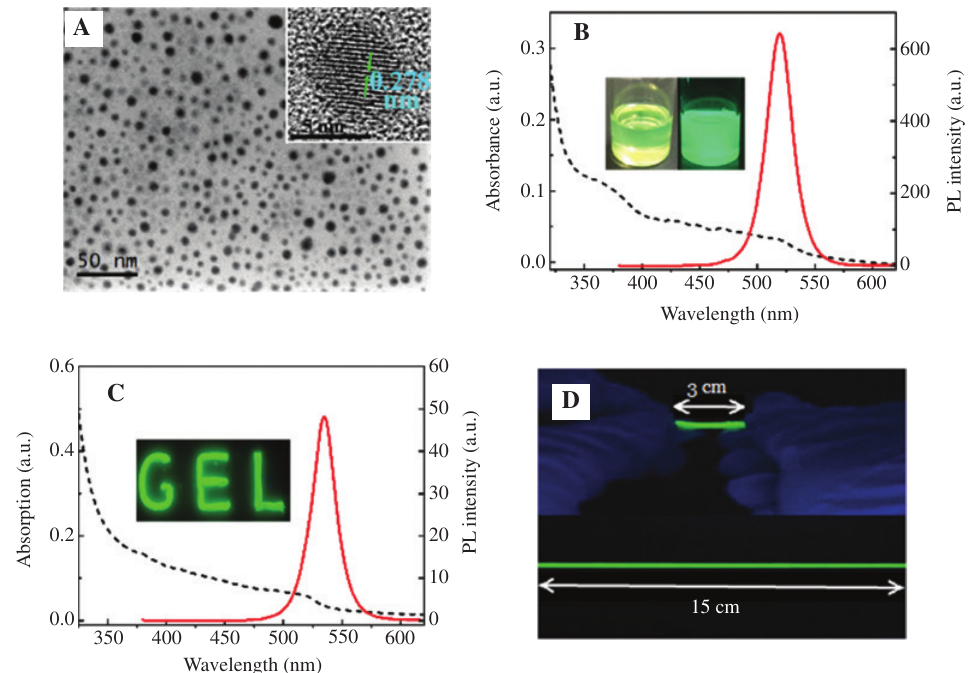
NCs. Inset: the HRTEM image; (B) UV-Vis absorption and PL spectra of the MAPbBr NCs 3 3 NCs under ambient light and UV light of 365 nm; (C) UV-Vis 3 (0.8 wt.%)/PDMS-urea gel, Inset: Photograph of the MAPbBr (0.8 wt.%)/PDMS-urea gel under 3 3 (0.8 wt.%)/PDMS-urea taken under 365 nm UV light. 3